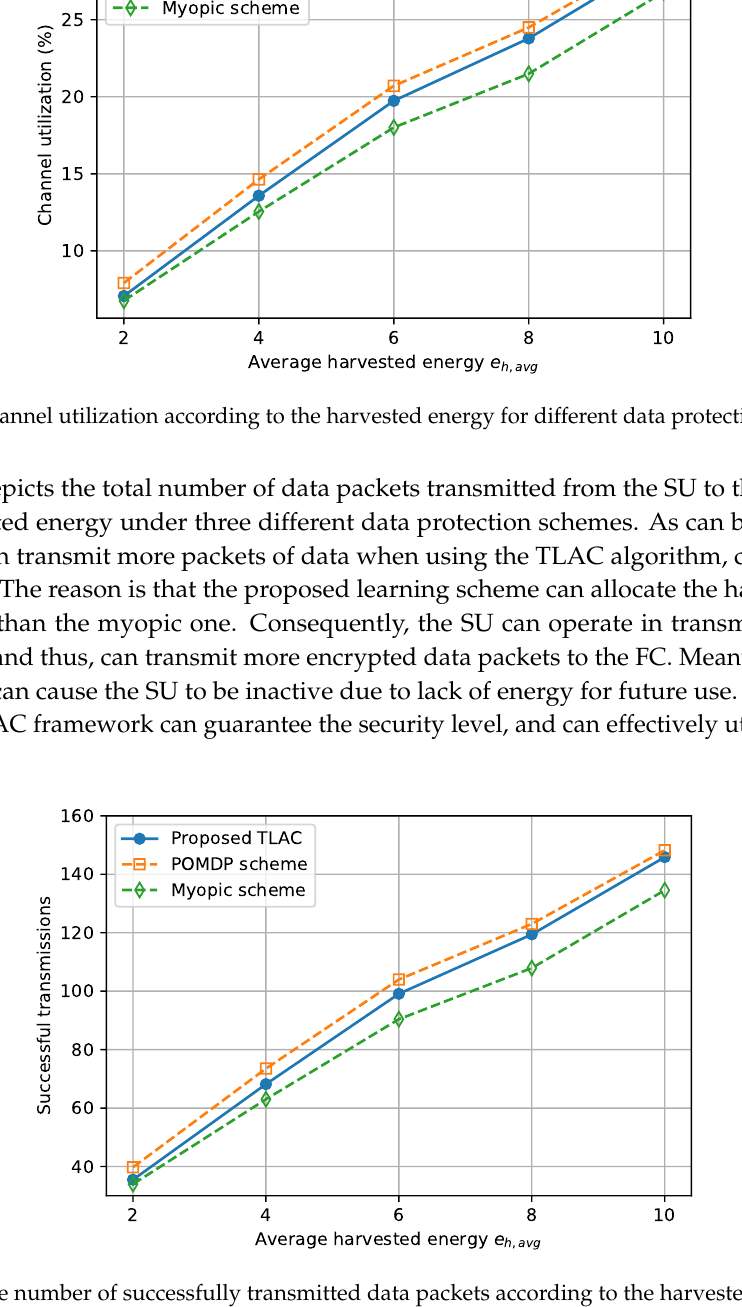
Figure 16. The number of successfully transmitted data packets according to the harvested energy for different data protection